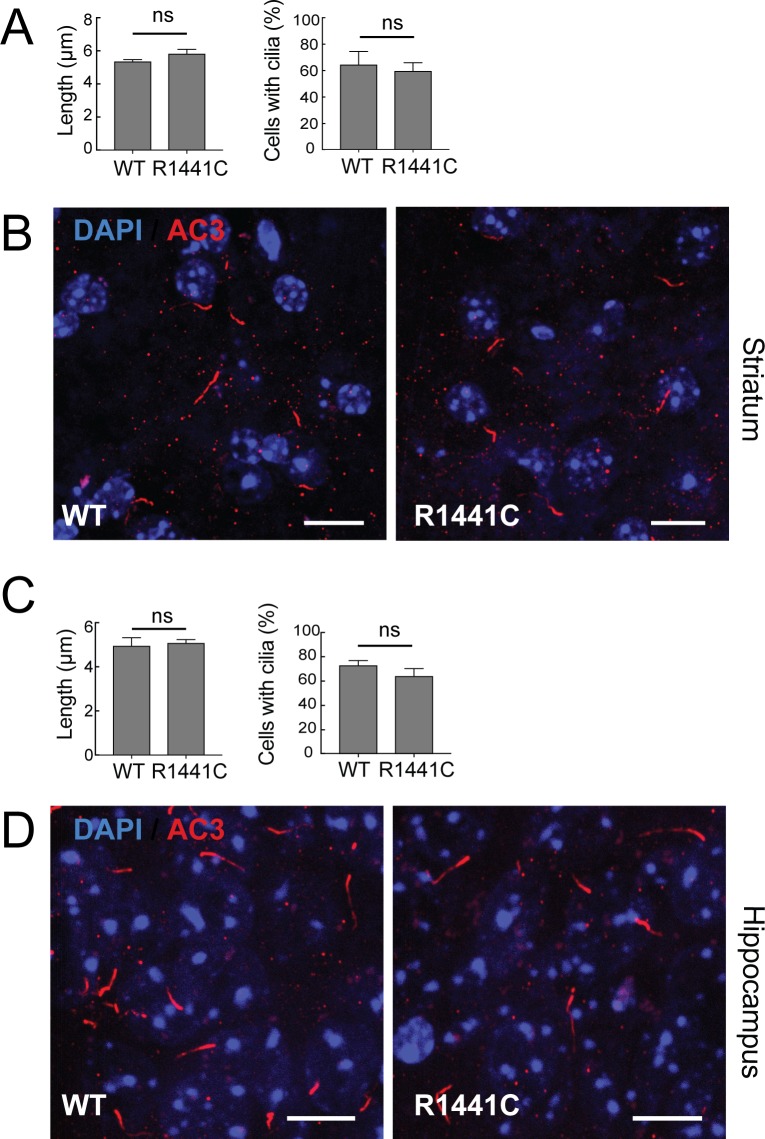
Neuronal primary cilia in hippocampus and striatum.Anti-Adenylate cyclase three staining for primary cilia in hippocampal (A–C) or striatal (D–F) regions of wild type and 7 month old LRRK2 R1441C mouse brains. (A,D) Length of primary cilia measured in µm. (B, E) Quantitation of neurons with primary cilia. (C, F) Representative images of brain sections stained with anti-AC3 antibodies (red) and DAPI (blue). Scale bar, 10 µm. Error bars represent SEM from four mice. WT and R1441C are indicated. p-values>0.05 were considered not significant (ns).